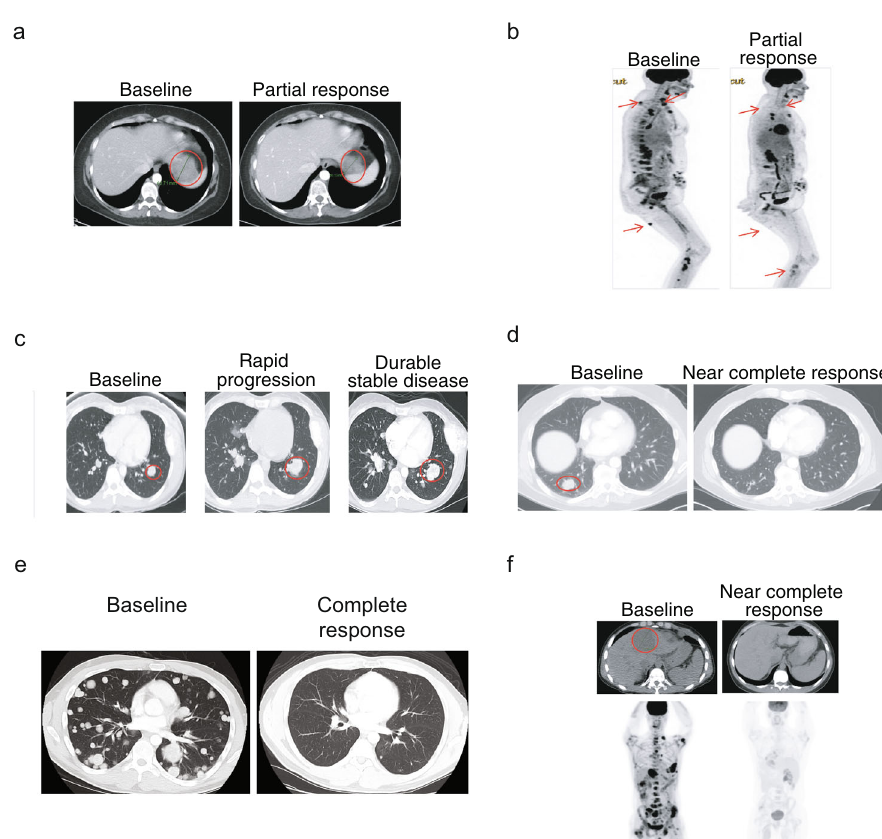
Fig. 6 Treatment outcomes of selected patients in whom sequencing identi fi ed an actionable alteration. a Advanced, metastatic sarcoma, NOS harboring a SMARCB1 deletion with durable partial response to tazemetostat, an EZH2 inhibitor. b Metastatic, refractory sarcoma harboring BRAF V600E with a rapid and near complete response to vemurafenib and trametinib. c Metastatic osteosarcoma with rapid progression on doxorubicin and cisplatin. After sequencing, identi fi cation of an ATM exon 57-truncating mutation, a combination of a PARP inhibitor and an investigational drug led to durable stable of >1 year. d Near complete response in metastatic, refractory undifferentiated pleomorphic sarcoma with high TMB (20 mut/Mb) treated with pembrolizumab. e Complete response in refractory malignant PEComa ( TFE3 fusion-negative, TSC1 subclonal) harboring intermediate tumor mutational burden (7 mut/Mb) treated with nivolumab and ipilumumab (compassionate, off-label). f Complete response in in fl ammatory myo fi broblastic sarcoma harboring an ETV6-NTRK3 fusion and treated with